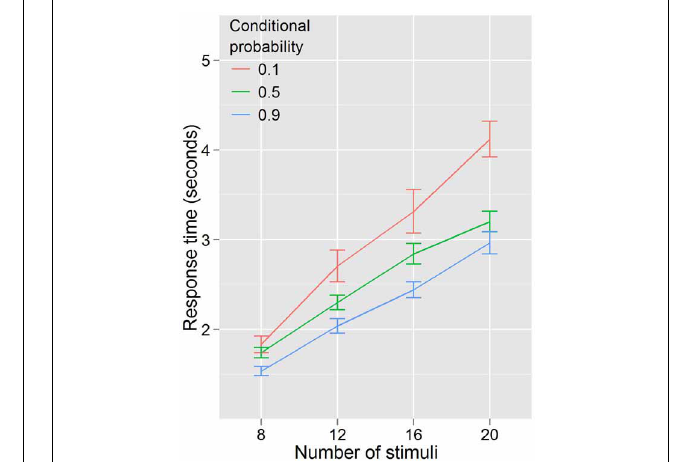
FIGURE 4 | Response times by distractor number for Experiment 2. When probability cuing is removed, search efficiency is equal regardless of color priming.